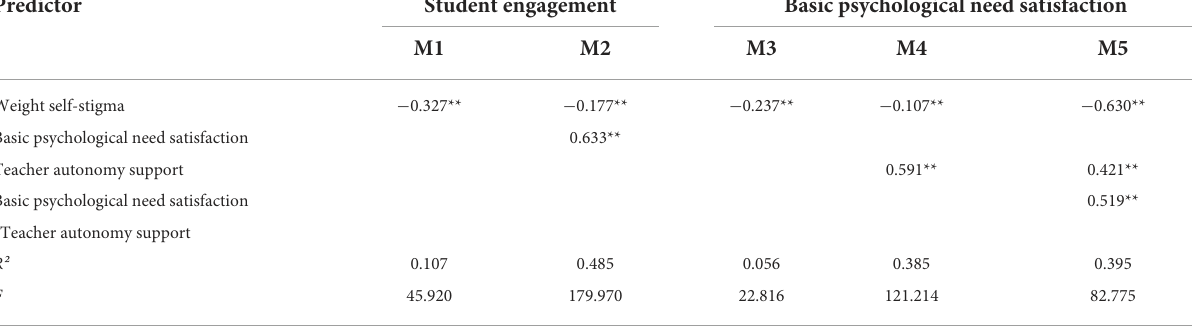
TABLE 4 A hierarchical regression analysis of the mediating effect of basic psychological needs. Predictor